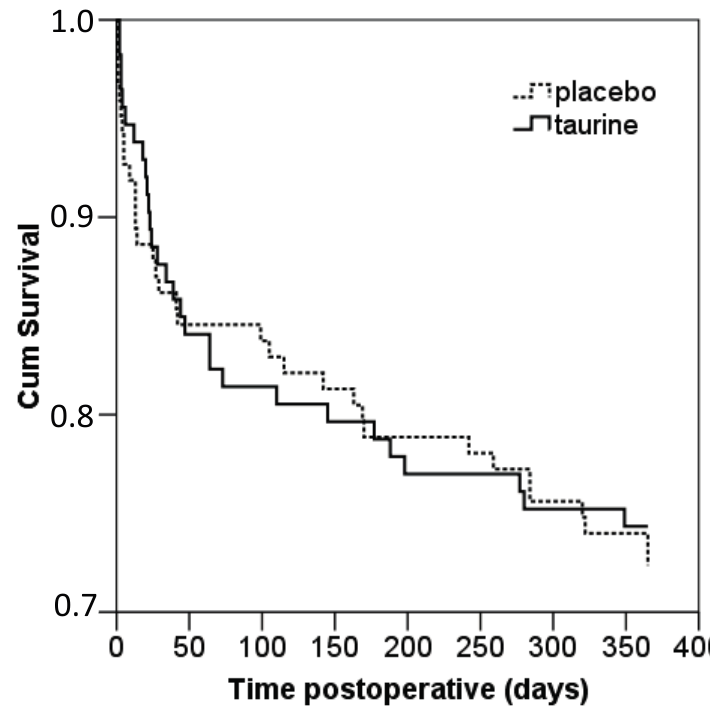
Figure 2. Kaplan Meier curve for mortality; 365 days after surgery. Intention to treat analysis; Log-rank =